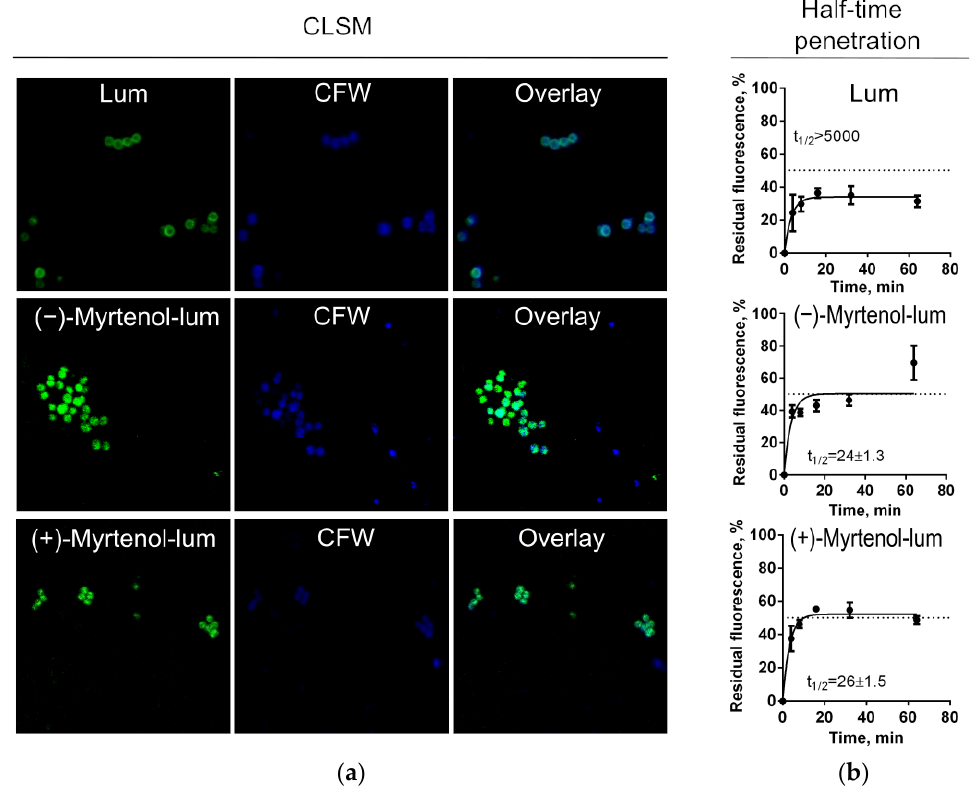
Figure 4. Myrtenol-lum penetration into S. aureus cells. (a) The localization of either ( − )-myrtenol or